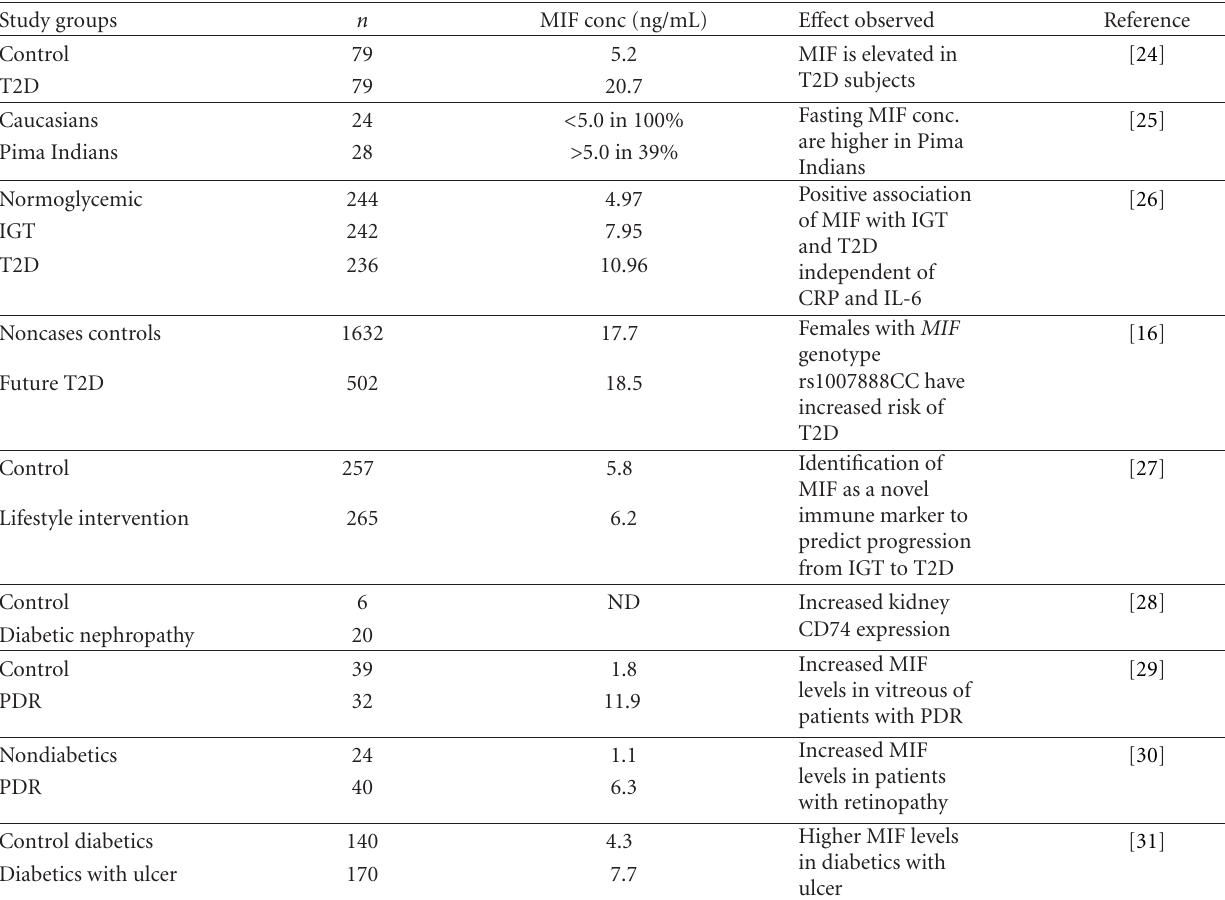
Table 2: Relationship between plasma MIF concentrations, glucose intolerance, and T2D. The table provides the type of subjects (study groups), the number of subjects per study group, and the plasma/serum MIF concentration together with the major e ff ects. IGT: impaired glucose tolerance; PDR: proliferative diabetic retinopathy; ND: not